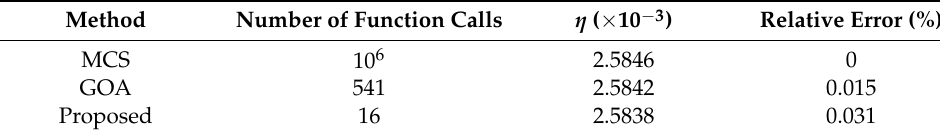
Table 2. Result comparison using different methods for Example